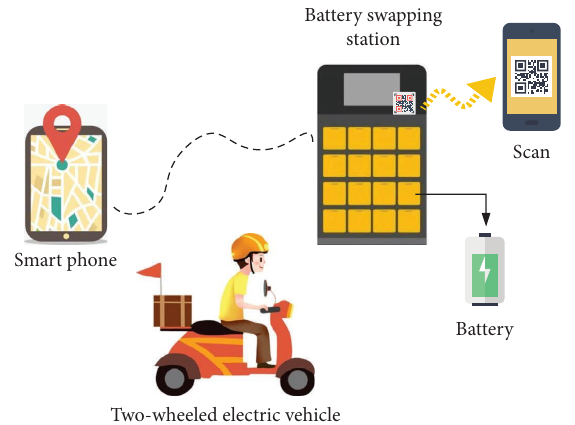
Figure 3: User battery swapping process.